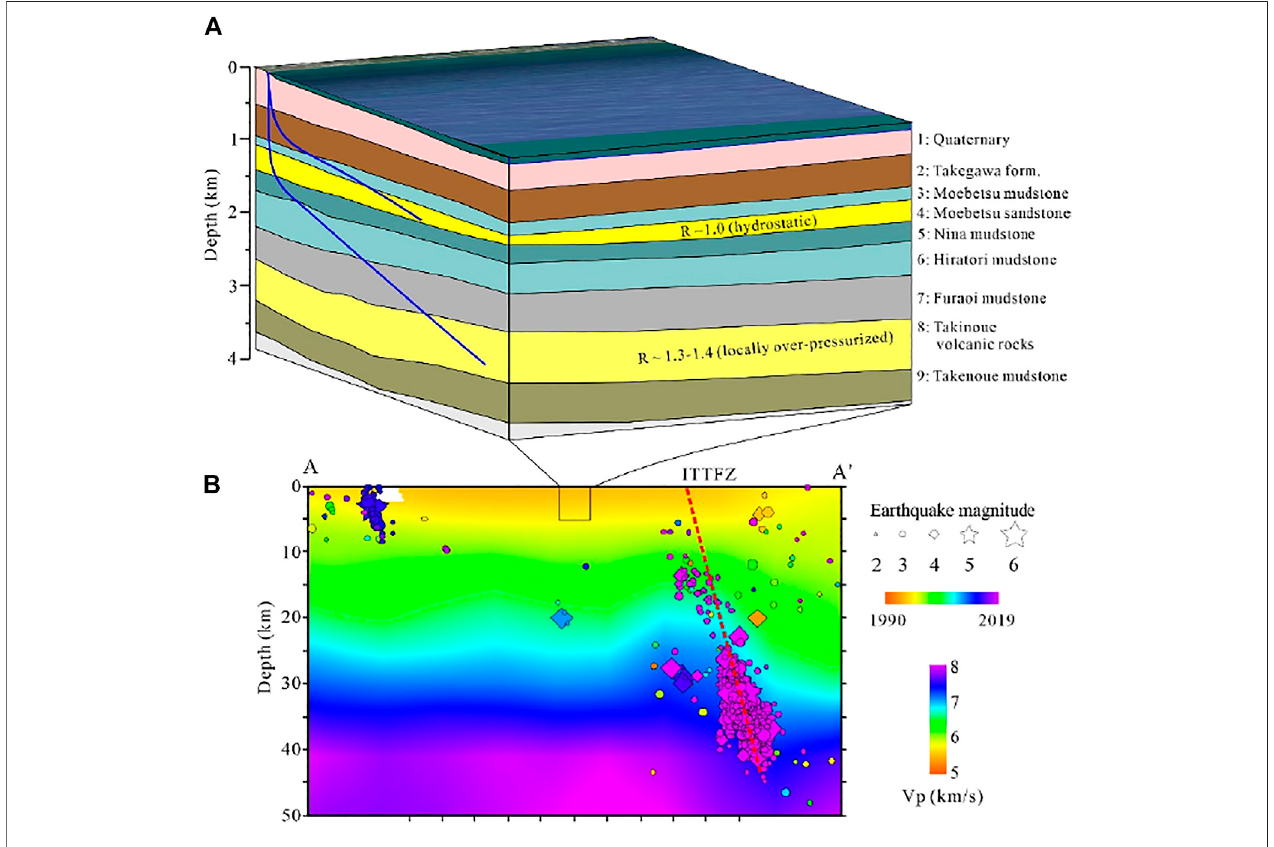
FIGURE 2 | (A) A simpli fi ed 3D geological model of the Tomakomai CCS-CO 2 injection site (modi fi ed from (METI, NEDO, and JCCS, 2020)). (B) Vertical section showing the P velocity (from (Matsubara et al., 2017)) and the earthquake (from JMA catalog) distribution. Ishikari-Teichi-Toen fault zone (ITTFZ).